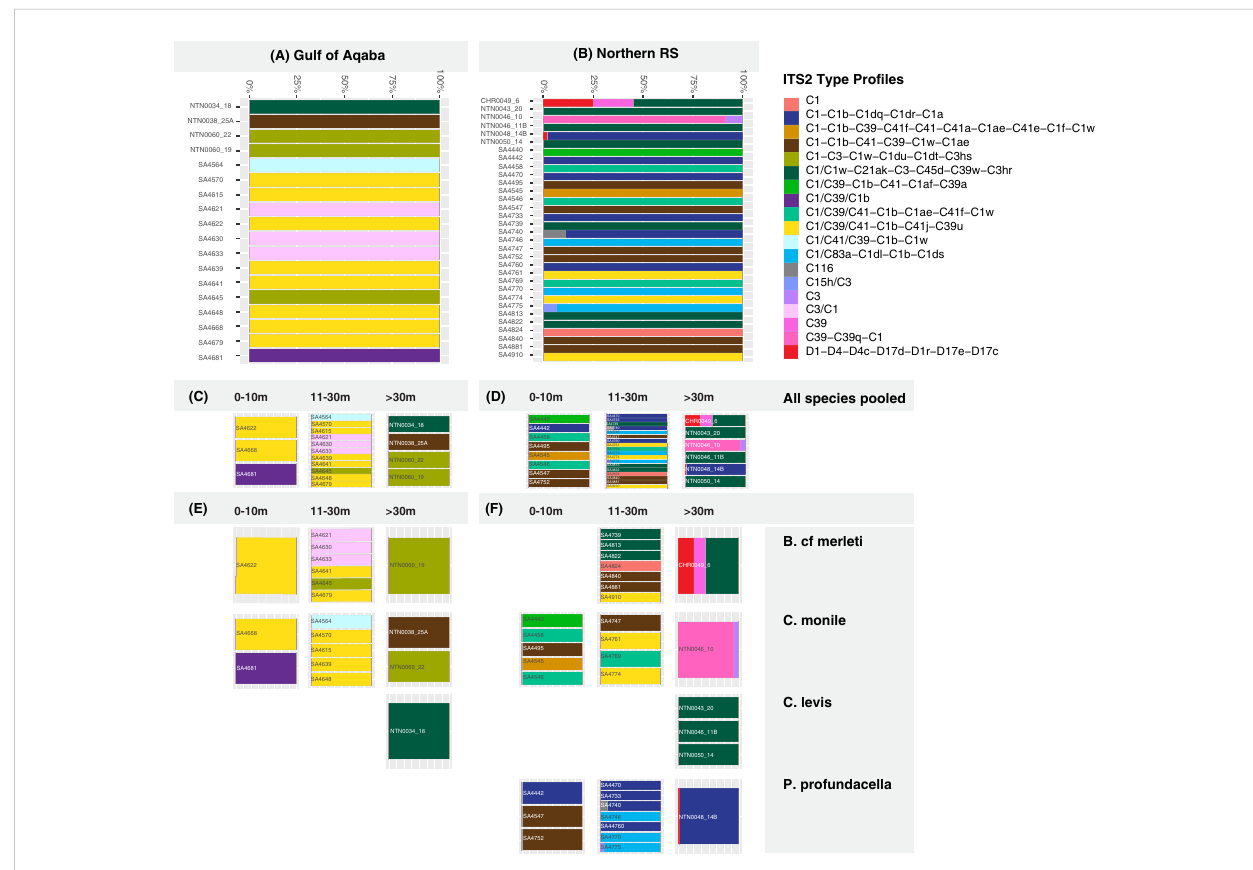
FIGURE 4 Predicted Symbiodiniaceae ITS2 pro fi les for the analyzed coral hosts in the Gulf of Aqaba (A) and in the northern Red Sea (B) at (C, D) three depth ranges (0-10, 11-30, >30 m) and for (E, F) four Scleractinia host species ( Blastomussa cf. merleti , Coscinaraea monile , Craterastrea levis , Psammocora profundacella ) at three depth ranges (0-10, 11-30, >30